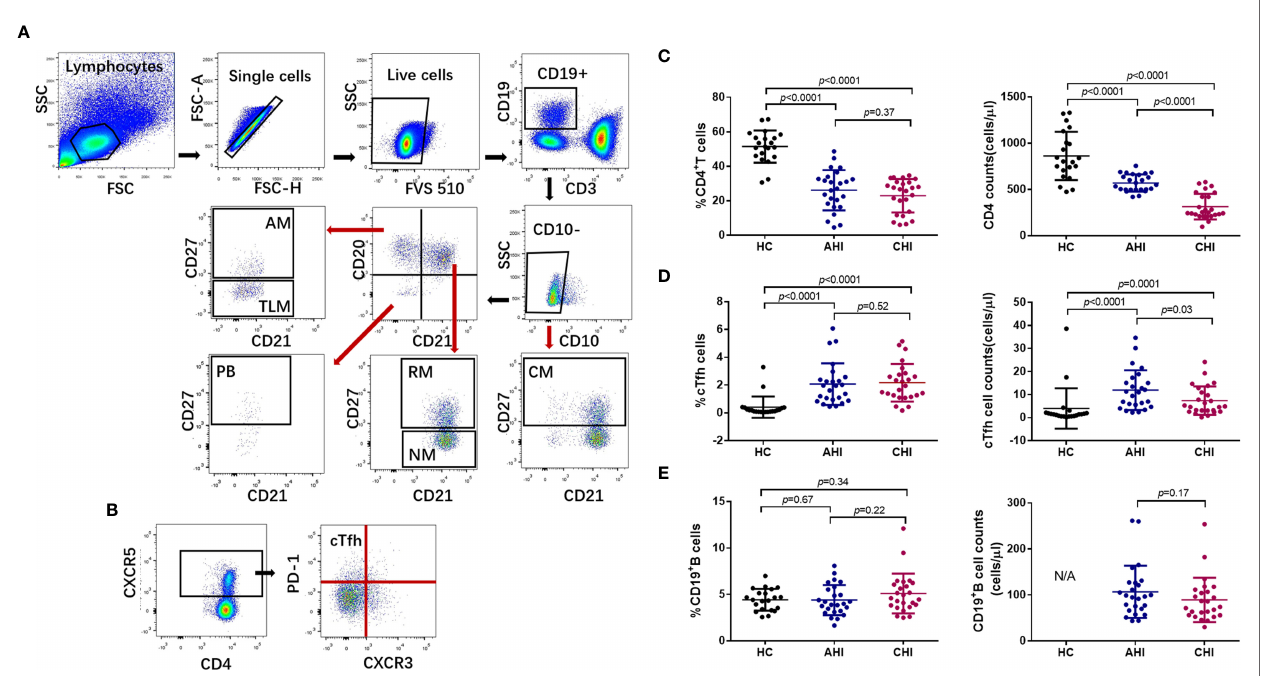
FIGURE 1 | Expansion of bulk cTfh cells after HIV-1 acute infection and persists into chronic stage. (A) The gating strategy for fl ow cytometric analysis of bulk B cell and B cell subsets in PBMCs. Among all events, forward angle and side scatter light gating were gated on lymphocytes and were used to exclude cell debris from the analysis. Forward height and forward area were used to exclude doublet cells, and cells were labeled with Live/Dead fi xable viability stain 510, and dead cells were excluded. Bulk B cells were de fi ned as CD19 + CD10 - , and were classi fi ed as classical memory (CM, CD27 + ), activated memory (AM, CD20 + CD21 - CD27 + ), tissue-like memory (TLM, CD20 + CD21 - CD27 - ), resting memory (RM, CD20 + CD21 + CD27 + ), naïve (NM, CD20 + CD21 + CD27 - ), and plasmablasts (PB, CD20 - CD21 - CD27 + ). FSC, forward scatter; SSC, side scatter. (B) Representative analysis of cTfh cells (CD3 + CD4 + CXCR3 - CXCR5 + PD-1 + ). (C – E) Comparison of the frequencies ( left ) and number ( right ) of bulk CD4 + T cells, cTfh cells, and B cells among healthy control (HC, n=21), acute HIV-1 infection stage (AHI, n=25), and chronic HIV-1 infection stage (CHI, n=25) groups. All data shown are means ± SD. N/A, data not